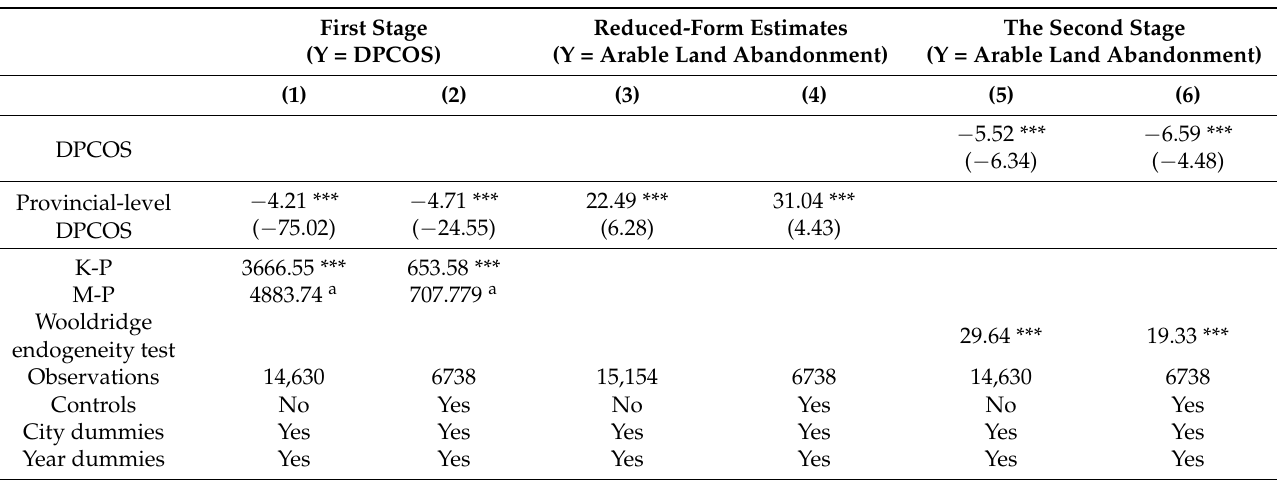
Table 4. Baseline results: The impact of DPCOS on arable land abandonment by using 2SLS.